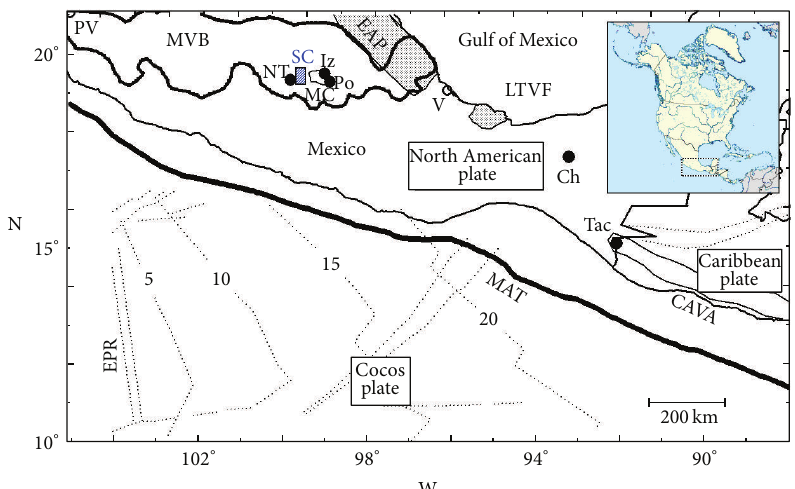
Figure 1: Location of the Sierra de las Cruces (SC) volcanic range (blue shaded box) at the central part of the Mexican Volcanic Belt (MVB) (modified from [30]). For guidance, the black box at the upper right side shows the location of this zone in North America. The figure also includes the approximate location of the Eastern Alkaline Province (EAP), Los Tuxtlas Volcanic Field (LTVF), Central American Volcanic Arc (CAVA), and the Chich´on (Ch) and Tacan´a (T) volcanoes. Other tectonic features are the Middle America Trench (MAT, shown by a thick black curve) and the East Pacific Rise (EPR, shown by a pair of dashed-dotted black lines). The traces marked by numbers 5 to 20 on the oceanic Cocos plate give the approximate age of the oceanic plate in Ma. Locations of Iztacc´ıhuatl (Iz), Popocat´epetl (Po), and Nevado de Toluca (NT) are also shown. Cities are PV: Puerto Vallarta, MC: Mexico City, and V: